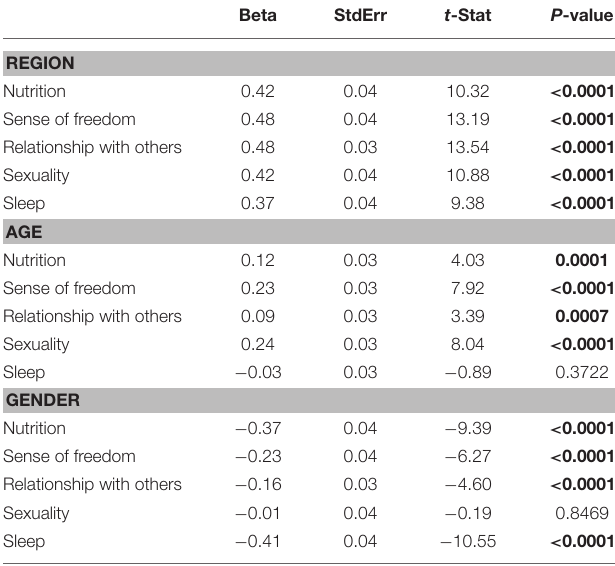
TABLE 3 | Multinomial logistic regression data for daily life activity category and demographic factors (region, age, and gender). Beta StdErr t -Stat P -value